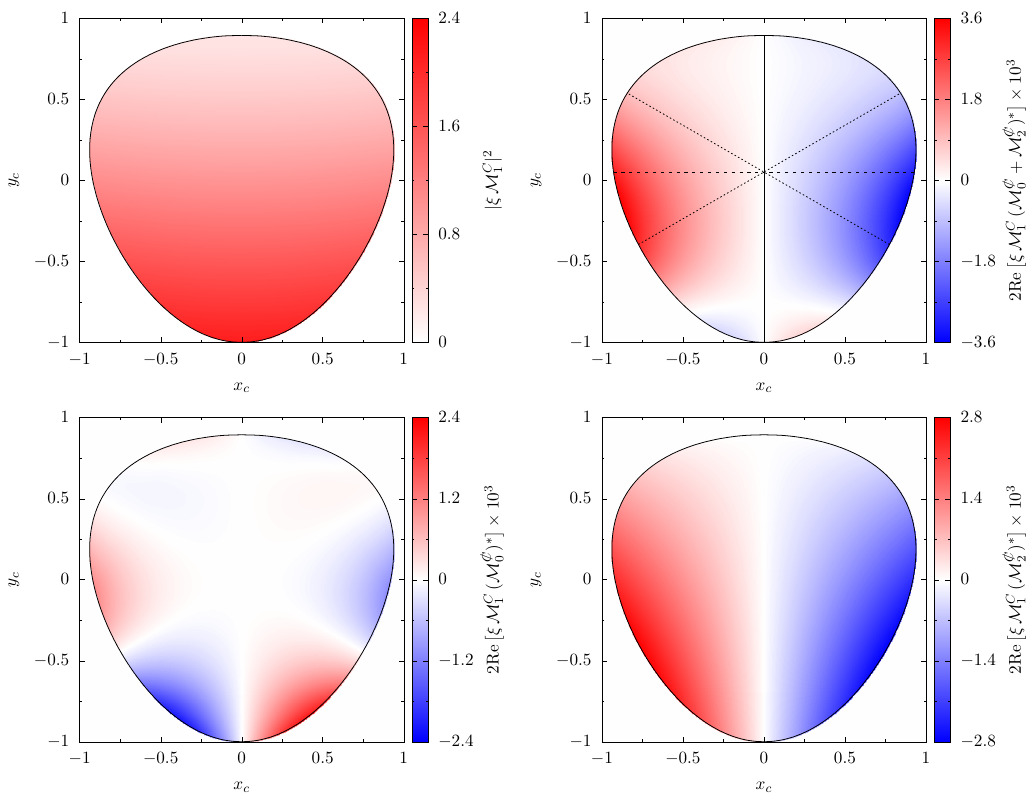
Figure 1 . Dalitz-plot distribution for η left), total C -violating contributions (top right), interferences of 6 C (bottom right). This is the corrected version of figure 5 in ref. 2 M